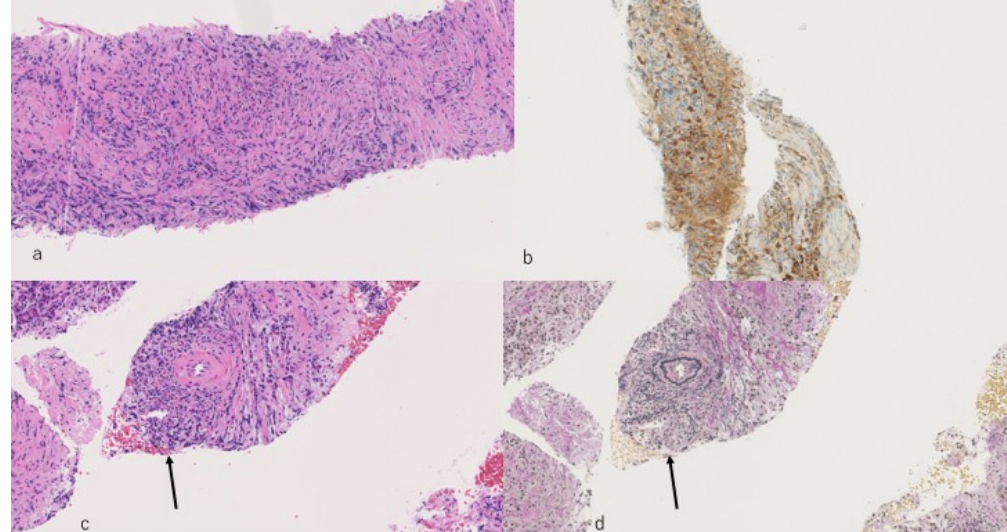
Figure 5. Histological findings obtained using an EUS-FNB needle. ( a ): Lymphoid cell infiltration and storiform fibrosis. ( b ): IgG4 positive plasma cell. ( c ): Obliterative phlebitis (HE) (arrow) ( d ): Obliterative phlebitis (Elastica van Gieson (EVG) staining) (arrow); EVG staining clearly shows findings of obliterative phlebitis.